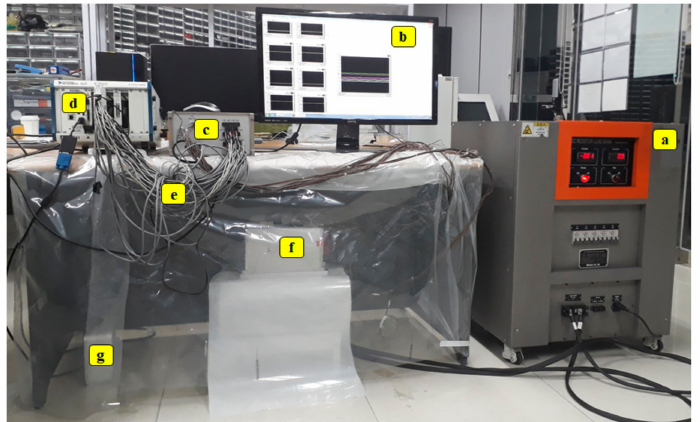
Figure 8. Realization of test setup with heat chamber on a single Li polymer pouch battery. ( a ) Load test unit, ( b ) Personal Computer, ( c ) transducer, ( d ) Data Acquisition System, ( e ) sensors, ( f ) test section, and ( g )